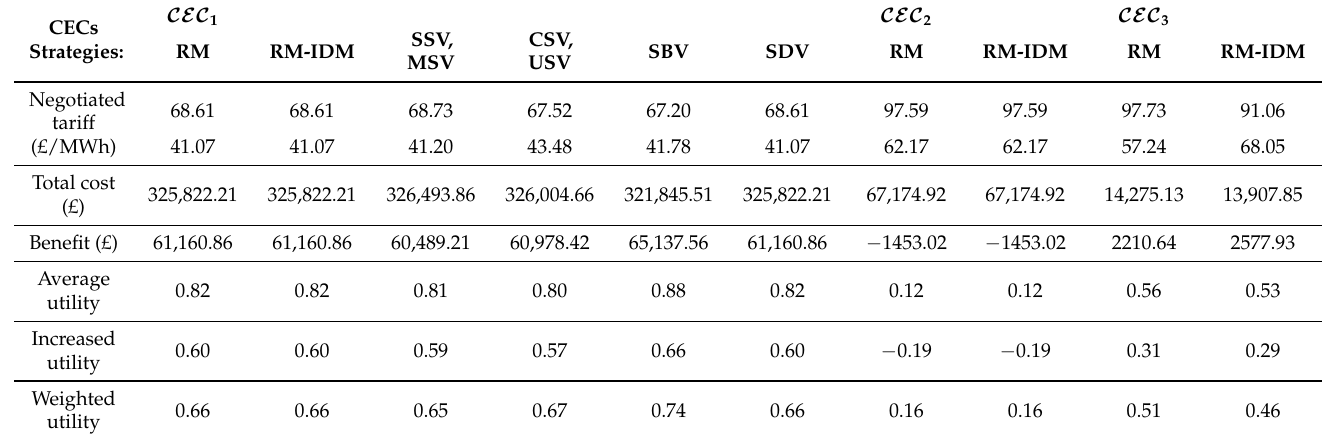
Table 5. Results of the case study: point of view of the